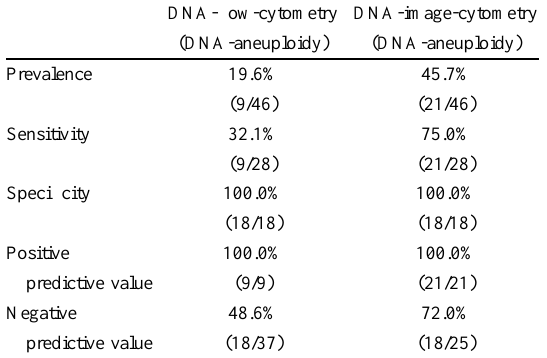
DNA-flow- and -image-cytometry in equivocal effusions DNA-flow-cytometry